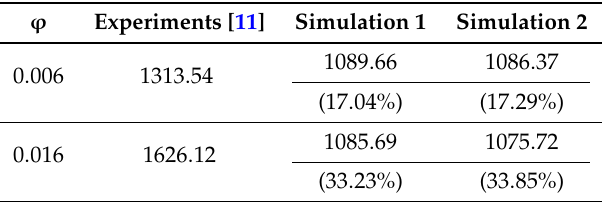
Table 2. Influence of the different correlations on the average heat transfer coefficient h av (W · m − 2 · K − 1 ) for Re = 1600, d np = 42 nm and Al 2 O 3 -water based nanofluids. The relative error is given in brackets. Simulation 1 combines Equations (7) and (10), whereas simulation 2 uses Equations (8) and (9). Results obtained using the single-phase model.